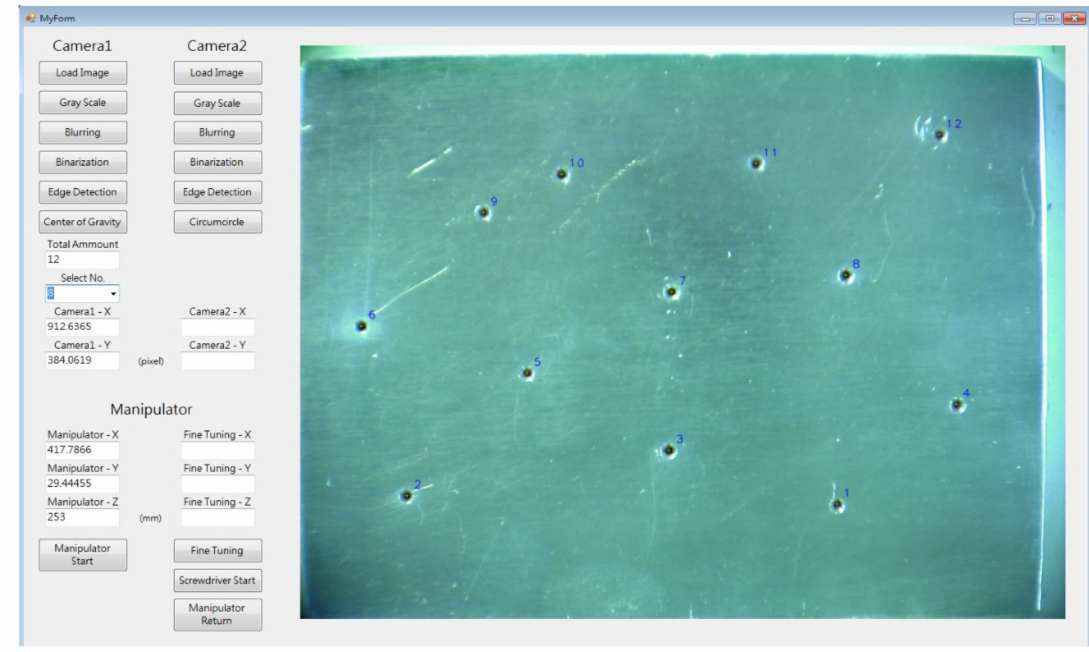
Figure 9. A photograph is captured using Camera 1, and the image is processed on the